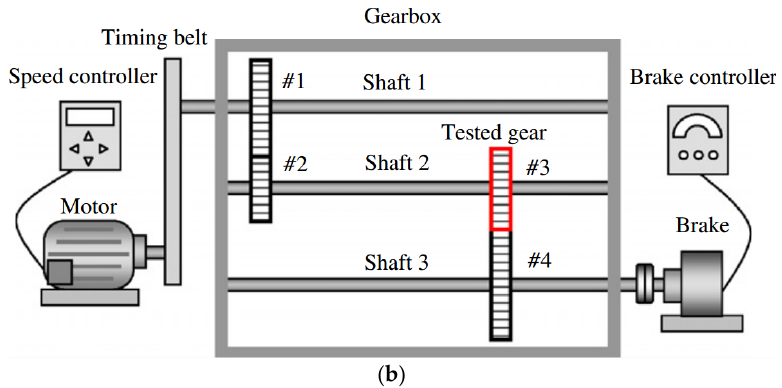
Figure 8. Gear test rig. ( a ) Experimental system; ( b ) diagram of the system.